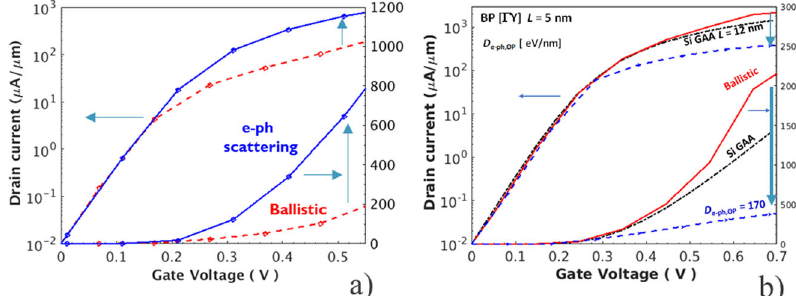
Fig. 4 Impact of electron – phonon scattering in 2D-material transistors. a I D ( V G ) characteristics of a L = 14 nm bi-layer WS 2 -DG nMOSFET computed with DFT-NEGF with and without e-ph. V D = 0.7 V. As q. V D is larger than the width of the bi-layer fi rst valley, the 1st valley electrons cannot travel ballistically from the channel to the drain and the ballistic current is reduced compared with the case with scattering. b I D ( V G ) characteristics of a L = 5 nm, 1ML-P 4 -DG nMOSFET computed with DFT-NEGF with and without e-ph. V D = 0.6 V. Owing to the strong optical- phonon coupling ( D OP = 170 meV/nm, ħ ω 0 = 32 meV) 43 , the drive current drops signi fi cantly when e-ph is included, despite the very-short- channel length. I OFF = 10 nA/ μ m. Γ Y (zigzag) channel orientation.